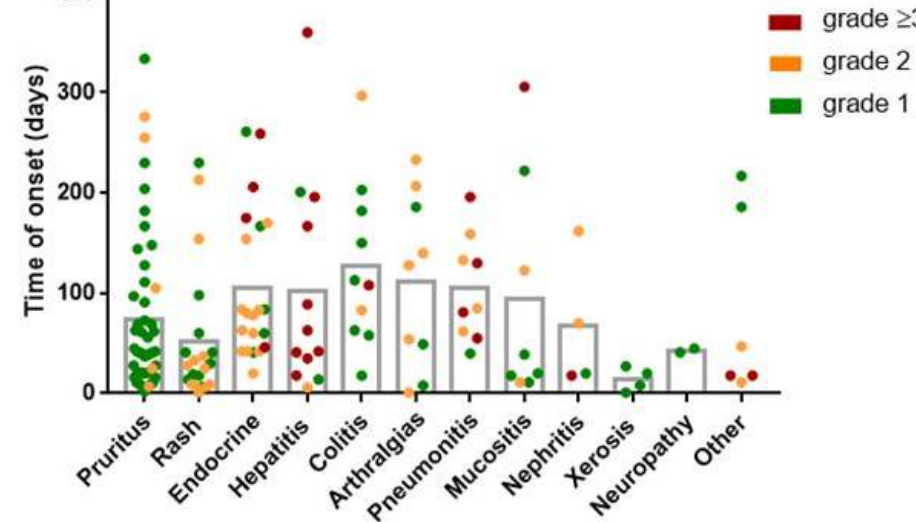
Figure 1. Description of immune-related adverse events. The time of onset and severity of the irAEs occurred in all patients in the study, according to the type of irAE. Each point represents an irAE ( n = 154). Types of irAE are ordered from the highest to the lowest frequency. Endocrine irAEs in- cluded hypothyroidism ( n = 12), hyperthyroidism ( n = 4, hypophysitis ( n = 4), and diabetes mellitus ( n = 1 ). Other irAEs include grade ≥ 3 myocarditis ( n = 1) and thrombocytopenia ( n = 1), grade 2 vasculitis ( n = 1) and psoriasis ( n = 1), and grade 1 myalgia ( n = 1) and vitiligo ( n = 1).